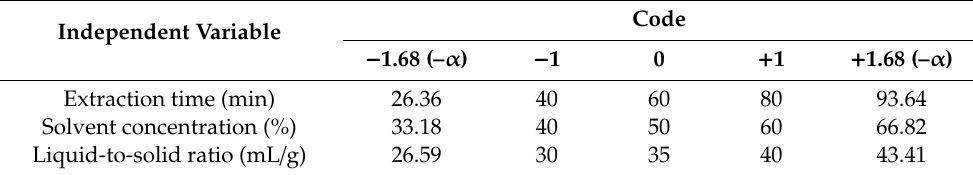
Table 3. Independent process variables with experimental ranges and levels of response surface